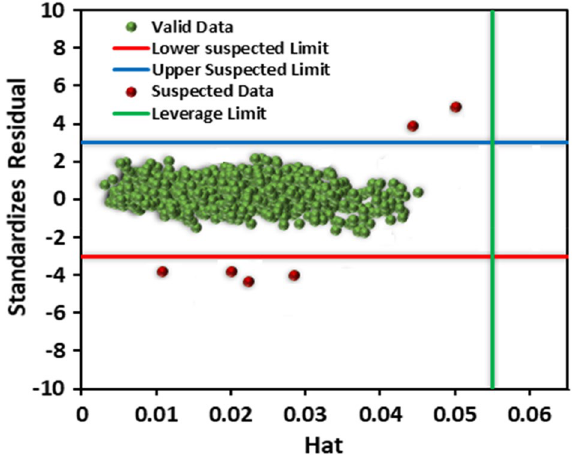
Figure 8. Outlier detection using William’s plot for the LightGBM